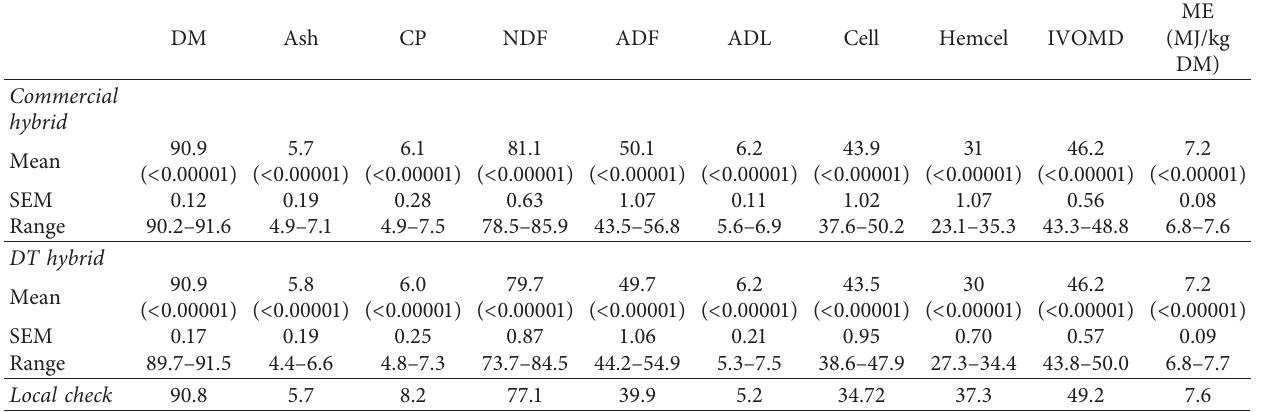
Table 3: Means of nutritional characteristics of commercial hybrid ( n � 11), drought-tolerant (DT) hybrid (41), and local check of different cultivar maize group. DM Ash CP NDF Cell Hemcel IVOMD